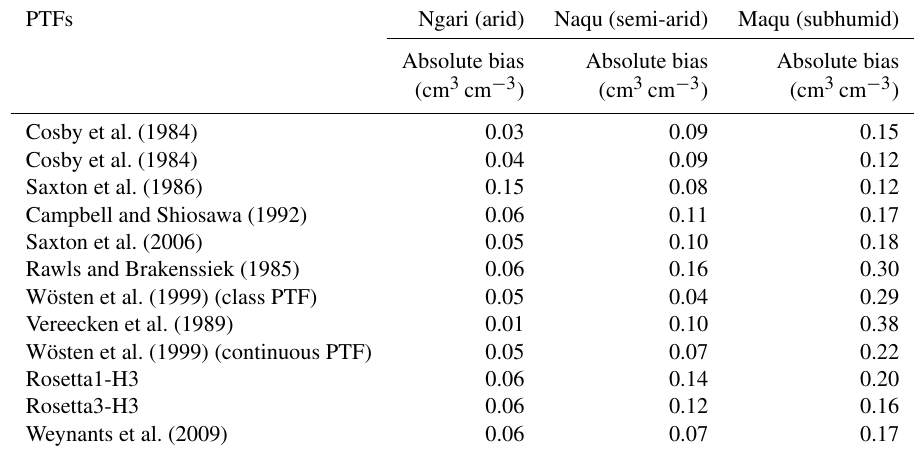
Table A4. Biases of estimated SWRCs from PTFs combined with the BD scheme and the measurements at 5cm at three climate zones. PTFs Ngari